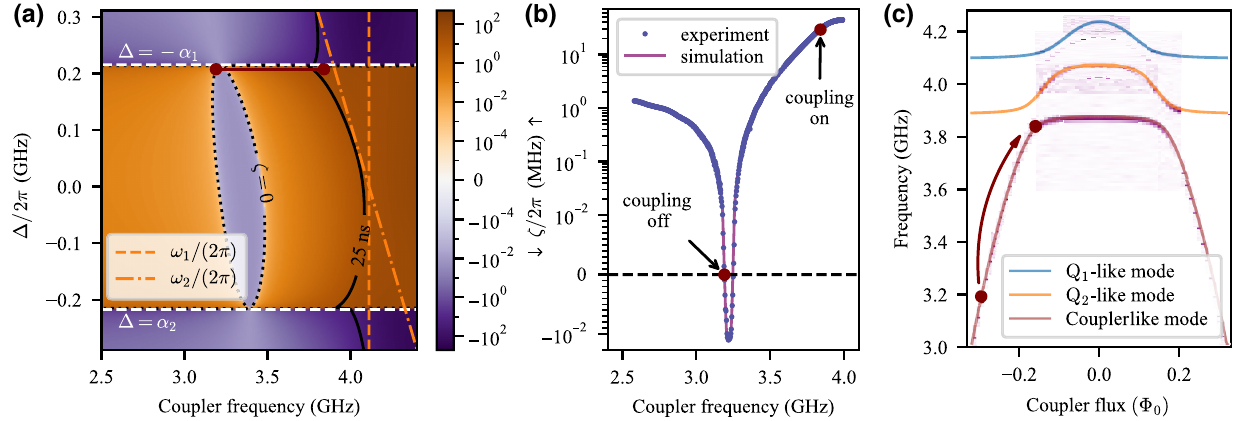
FIG. 2. (a) The effective ZZ interaction strength ζ between the qubits is shown as a function of the coupler frequency ω c / 2 π and the frequency detuning between the two qubits, (cid:5)/ 2 π . If α 2 < (cid:5) < − α 1 , there exists a contour (black dotted line) along which the ZZ interaction vanishes. The qubit frequencies are shown with orange dashed lines and the detuning values corresponding to their anharmonicities are marked with white dashed lines. The solid black line indicates the lowest coupler frequency at which a conditional phase of φ 11 = π can be accumulated in 25 ns. The solid red line illustrates the path along which the coupler is operated in the experiments. (b) The experimentally measured interaction strength (dots) as a function of the coupler frequency ω c / 2 π in units of flux quanta (cid:10) 0 for the specific qubit-qubit detuning chosen to implement the CZ gate. The numerical model (purple line) is fitted to the data to extract the coupling strengths between the two qubits and between each qubit and the coupler. (c) The experimentally measured eigenfrequencies (white to blue spectrum) and fitted eigenfrequencies (lines) of the qubits and the coupler as a function of the external threading through the coupler superconducting quantum interference device (SQUID) loop. The coupler spectrum below flux (cid:10) c ext as an ancilla (see Appendix F). The red circles show the idling and the operation configuration of the 3.7 GHz is measured using Q 2